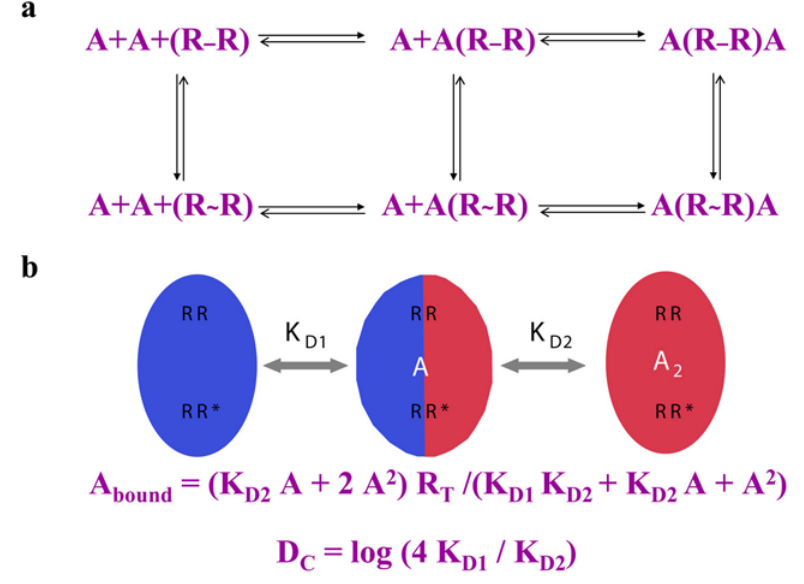
FIGURE 1. Scheme and equations of the two-state dimer model. (a) Model including all equilibria between inactive receptor dimers (RR), active receptor dimers (RR*), and the corresponding dimers with one or two ligand (A) molecules[18,19]. (b) Simplified model including macroscopic equilibrium dissociation constants (K D1 and K D2 ), and a simple equation for the ligand bound as a funtion of R T , K D1 , and K D2 , [A] and [A] 2 . Binding data can be fitted to this simple equation using any nonlinear regression approach. The equation for calculating the dimer cooperativity index (D C ) is also displayed; D C can be readily obtained from K D1 and K D2 values[10].